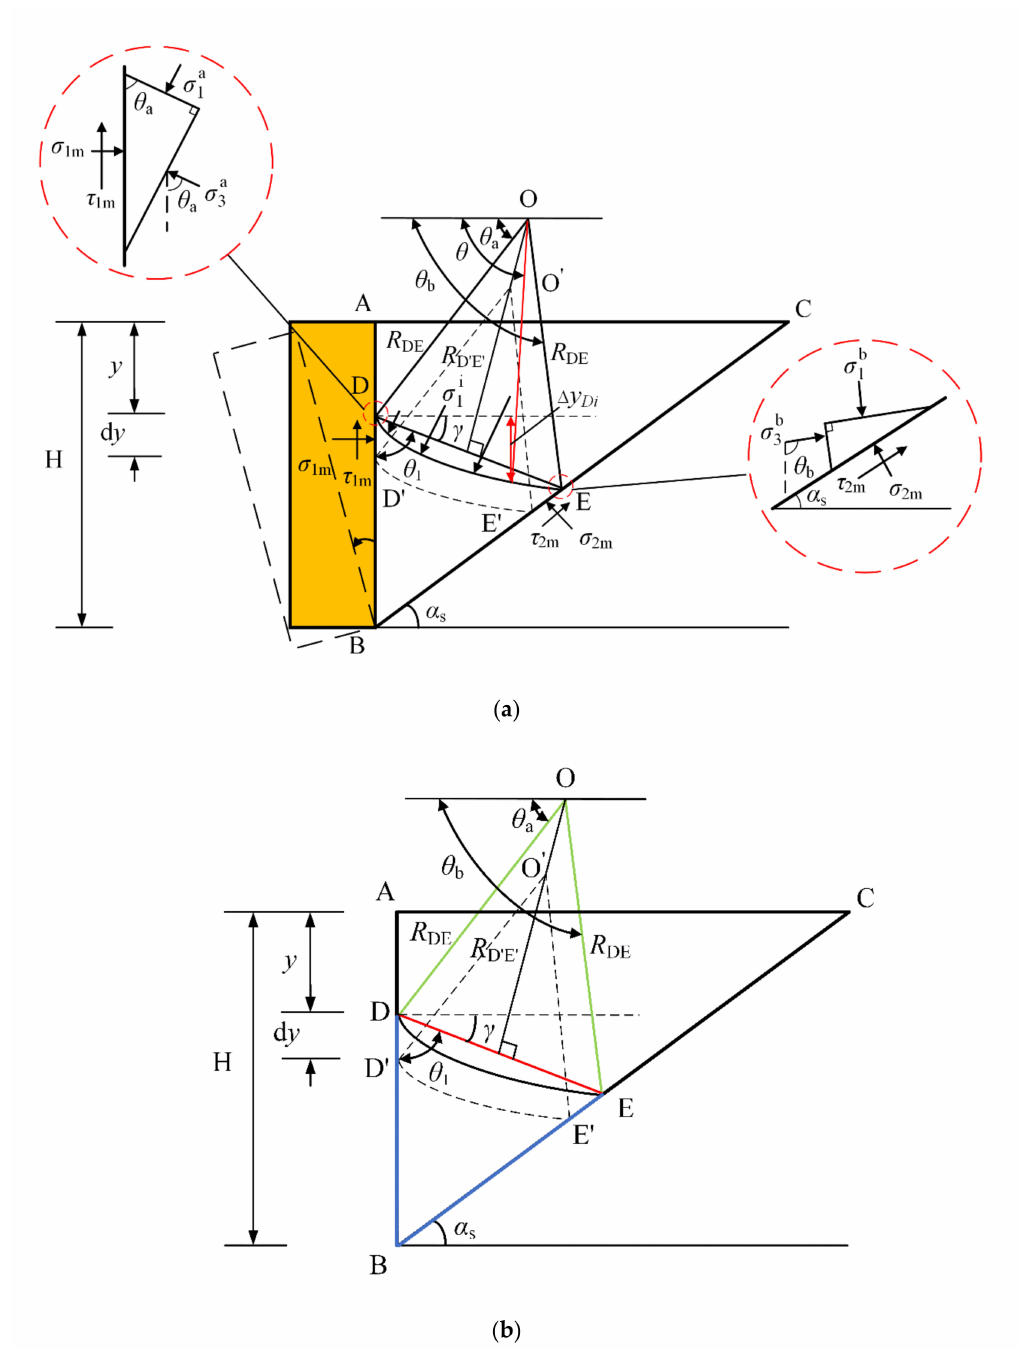
Figure 2. ( a ) Definition of small principal stress traces parameters. ( b ) Definition of arc trace